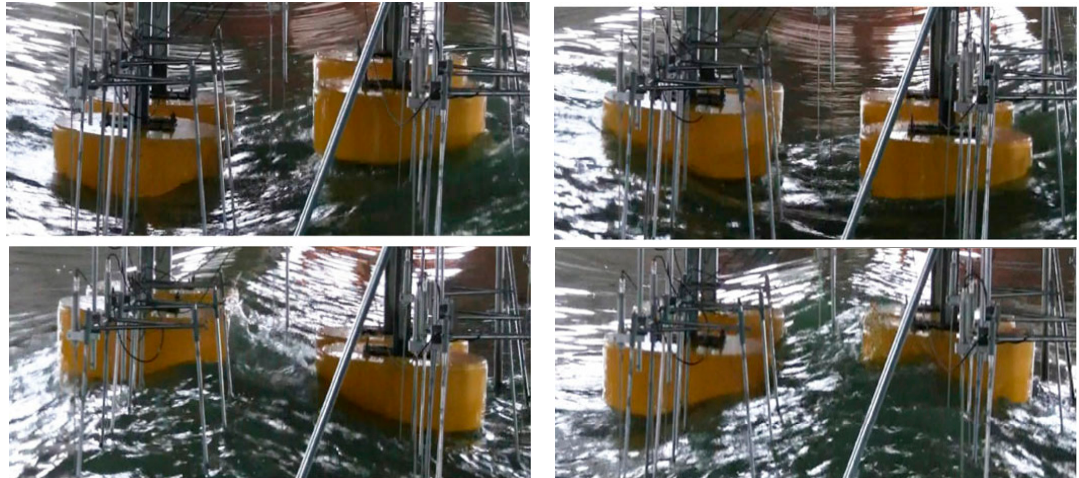
Figure 8. Snapshots of heaving buoys under wave excitation.